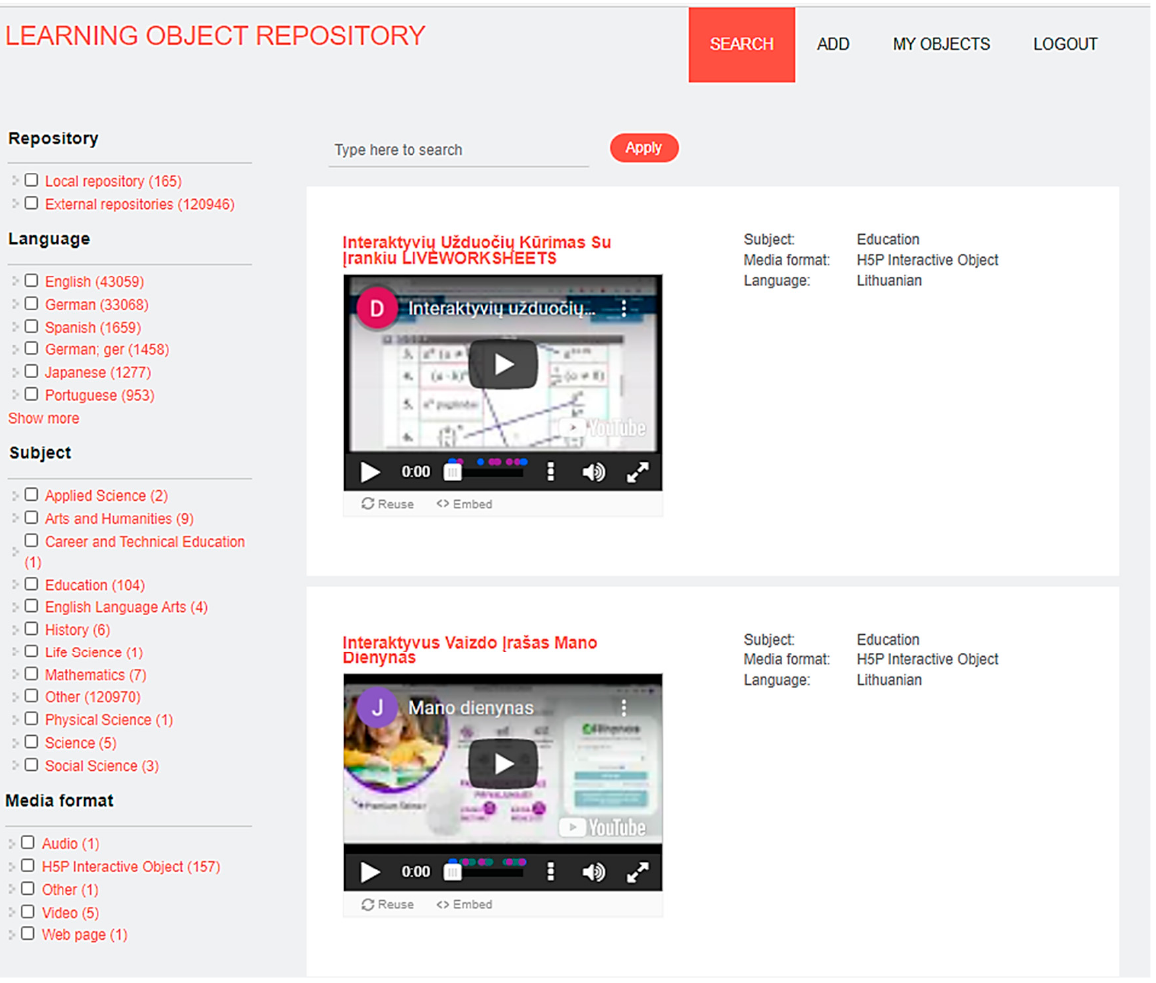
Figure 7. Multifunctional platform based on search, design and adaptation processes.